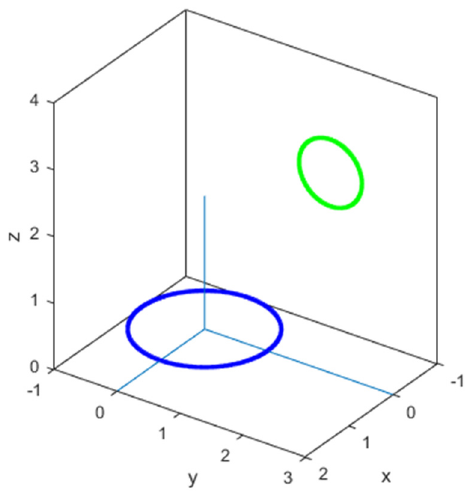
Figure 9. Case (a): two perpendicular circular loops. Not a singular case, ( a = 1, b = c = 0, L = l = 1).